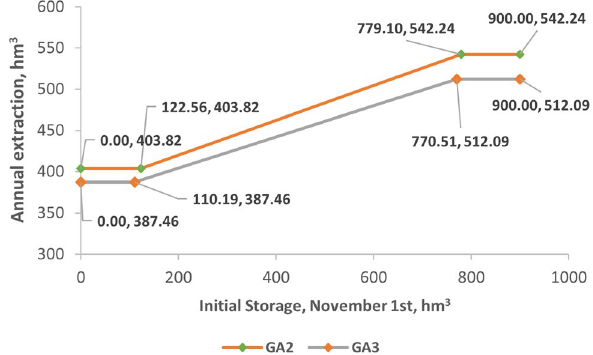
Fig. 14 The optimized Z curve portraying the annual extraction of water with genetic algorithm GA3 versus GA2